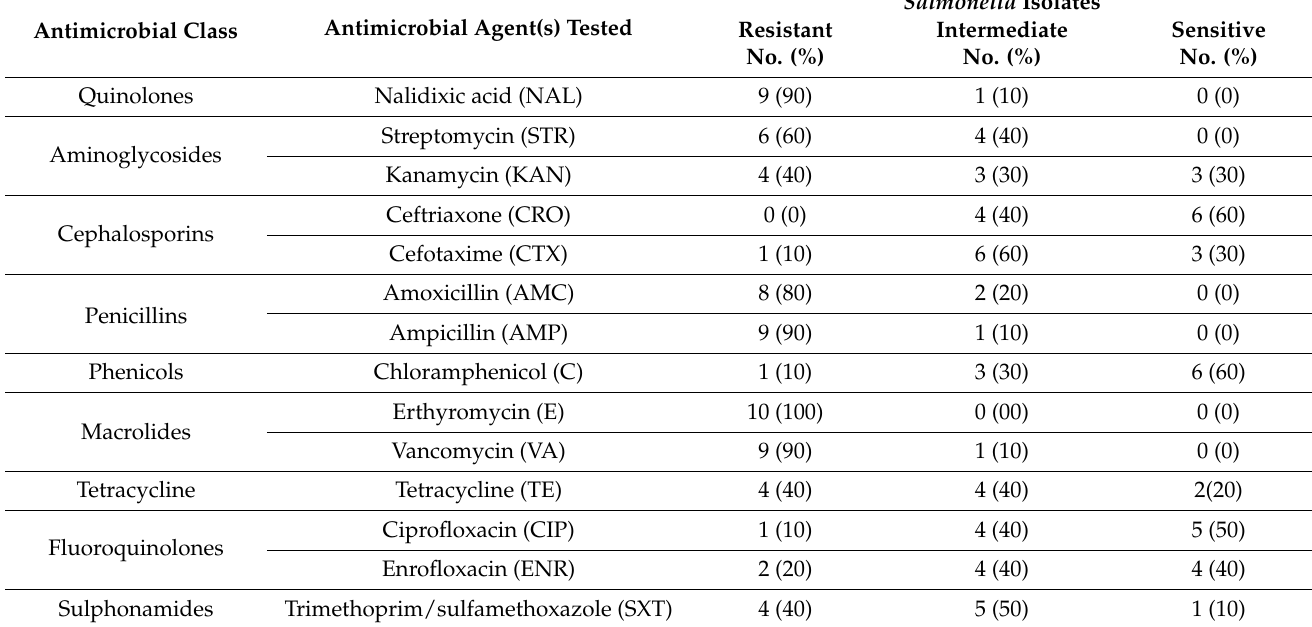
Antimicrobial Class Antimicrobial Agent(s)